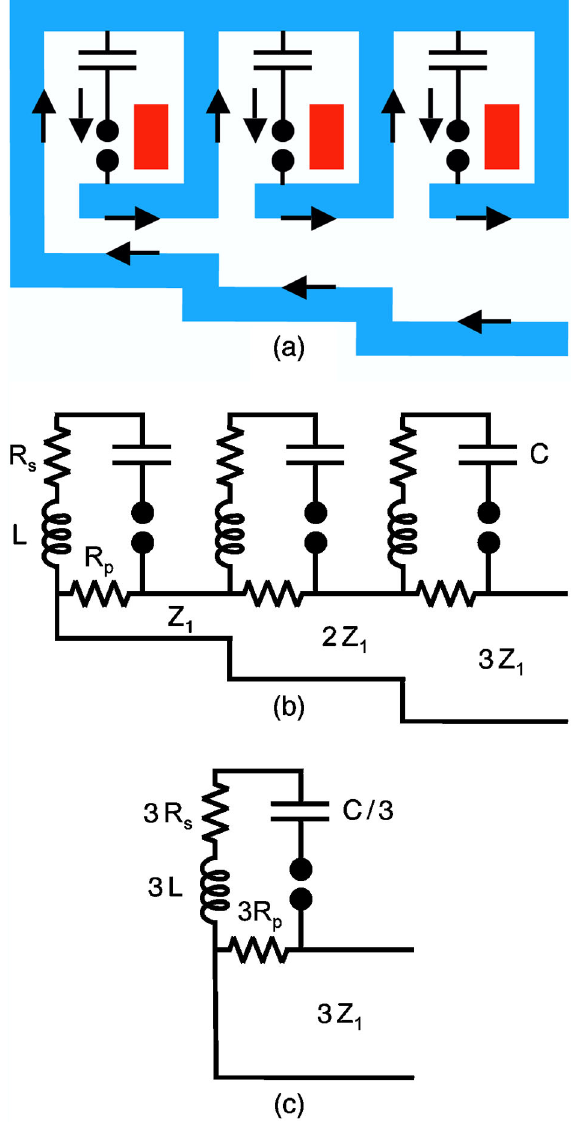
FIG. 3. (Color) (a) Idealized representation of an LTD module with three identical cavities connected in series. A cavity nor- mally contains a number of capacitors and switches; these are represented here by a single capacitor and a single switch. The red rectangles represent inductive high-permeability magnetic cores. The arrows represent the path of most of the current flow, after all the switches in the cavities have closed. A small fraction of the current flows around the cores. The LTD module assumed in this article consists of 60 identical cavities. (b) Circuit model of the three-cavity module. (c) Equivalent circuit model of the module. The circuit of (c) is valid only when the switches of each cavity close at a time (cid:1) c later than the closure of the switches in the cavity immediately upstream (i.e., immediately to the left), where (cid:1) c is the time it takes an electromagnetic pulse to propagate (down the internal transmission line) the length of a single cavity. (cid:1) c is the one-way transit time of a single transmission-line segment. We make the simplifying assumption that all the cavities, and all the transmission-line segments, have the same electrical